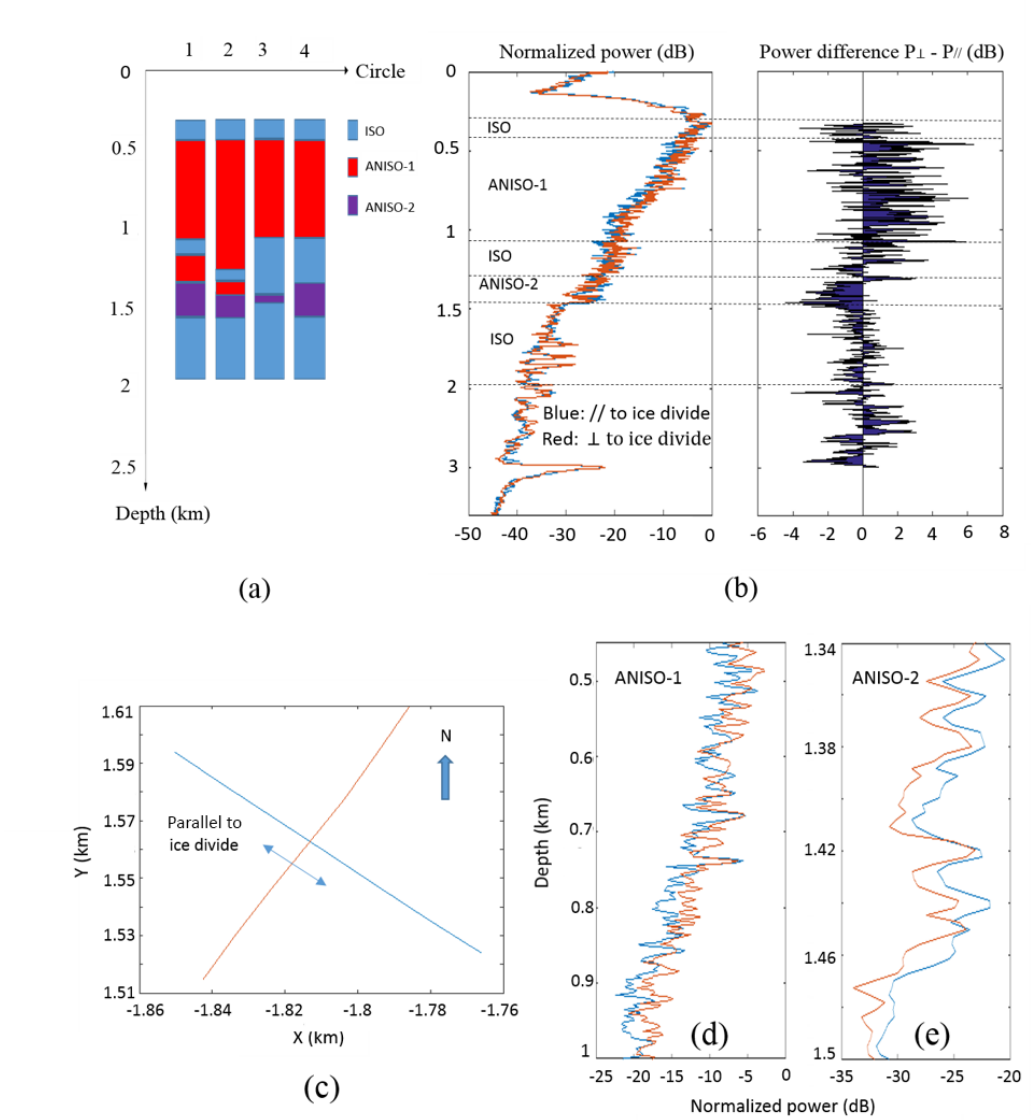
Figure 7. (a) Power variation patterns and their depth profiles for the HH polarimetric measurements at the four circles. ISO indicates no obvious anisotropy observed. ANISO-1–ANISO-2 are anisotropic patterns and indicate the ice optic axis is perpendicular or parallel to the ice divide. (b) Stacked normalized power–depth profiles and their differences at a crossover from non-polarimetric measurements with HH antenna configuration. The normalization is done by dividing both profiles by the maximum of the red one at 327m. The plot of the differences is area-filled. (c) Paths of the crossover (see the cross mark in Fig. 2a for its location relative to the four circles). (d) Anisotropic pattern ANISO-1 at the crossover. (e) Anisotropic pattern ANISO-2 at the crossover.